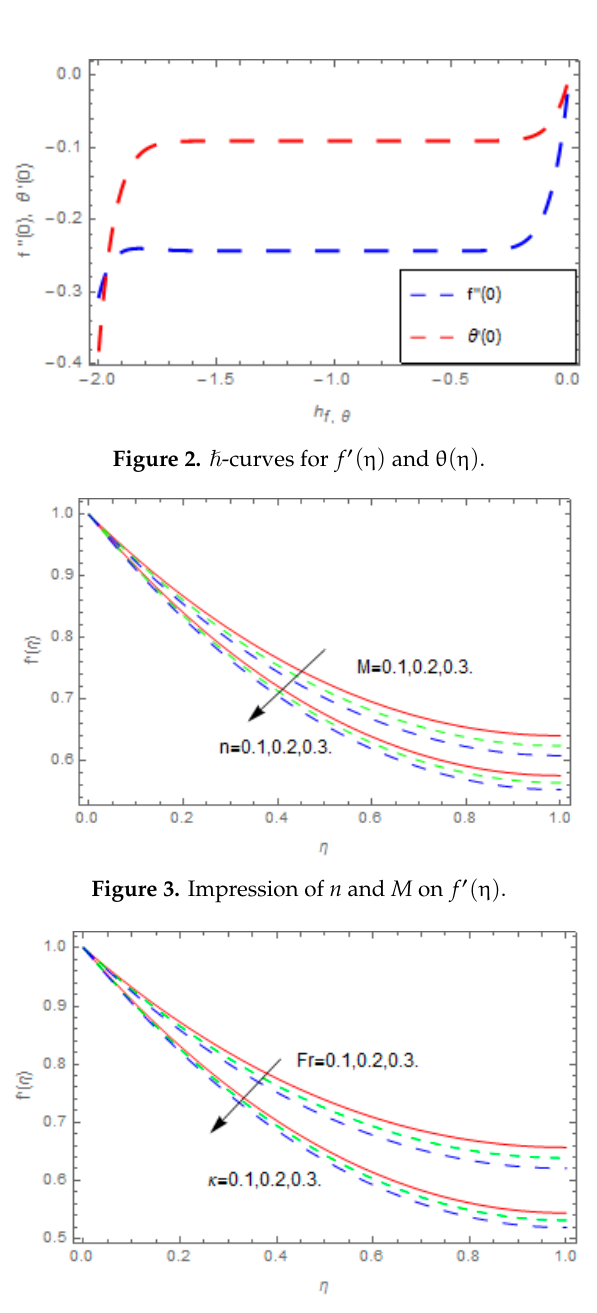
Figure 4. Impression of κ and F r on f (cid:48) ( η ) .